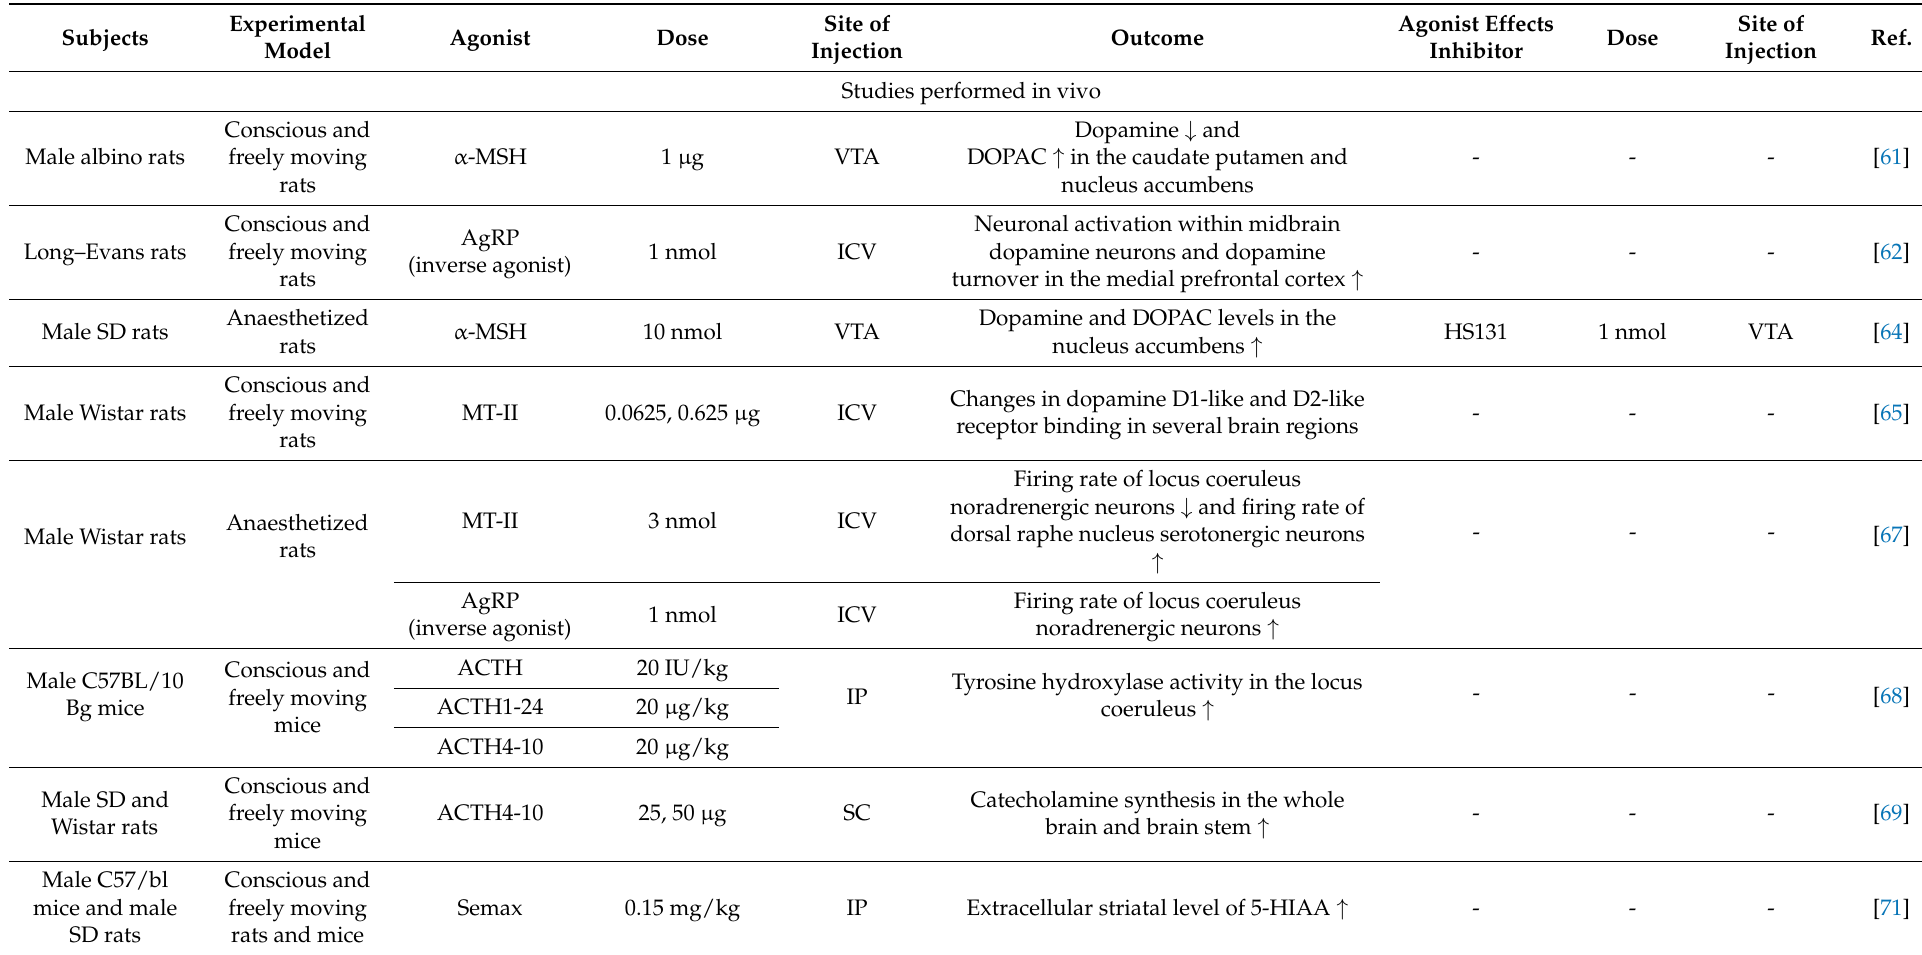
Table 2. A summary of the effects of melanocortin agonists on dopaminergic, serotonergic and noradrenergic